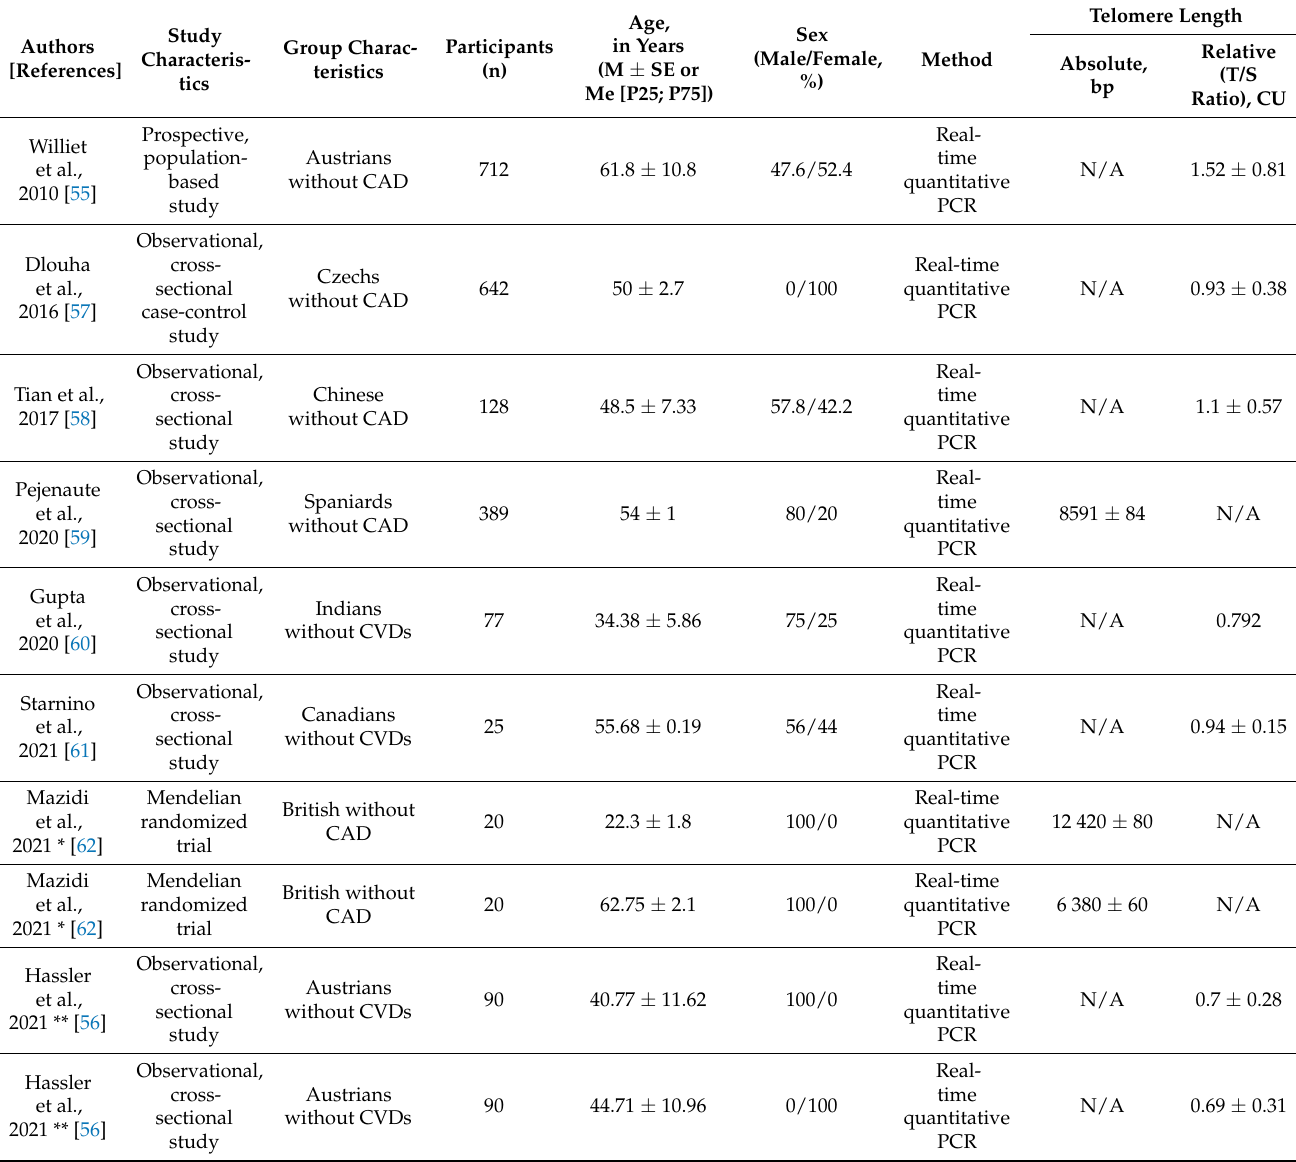
Table 1. Mean Relative Telomere Length of Leukocytes in Adults without Cardiovascular